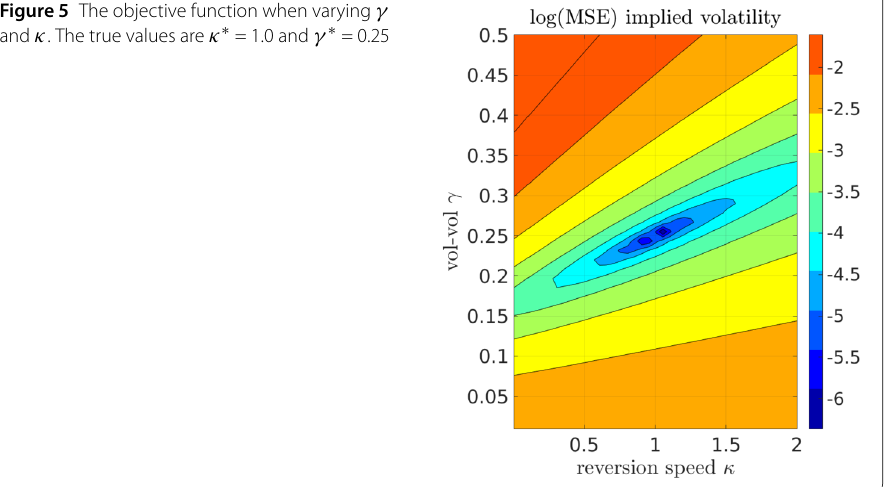
Figure 5 The objective function when varying γ and κ . The true values are κ ∗ = 1.0 and γ ∗ =